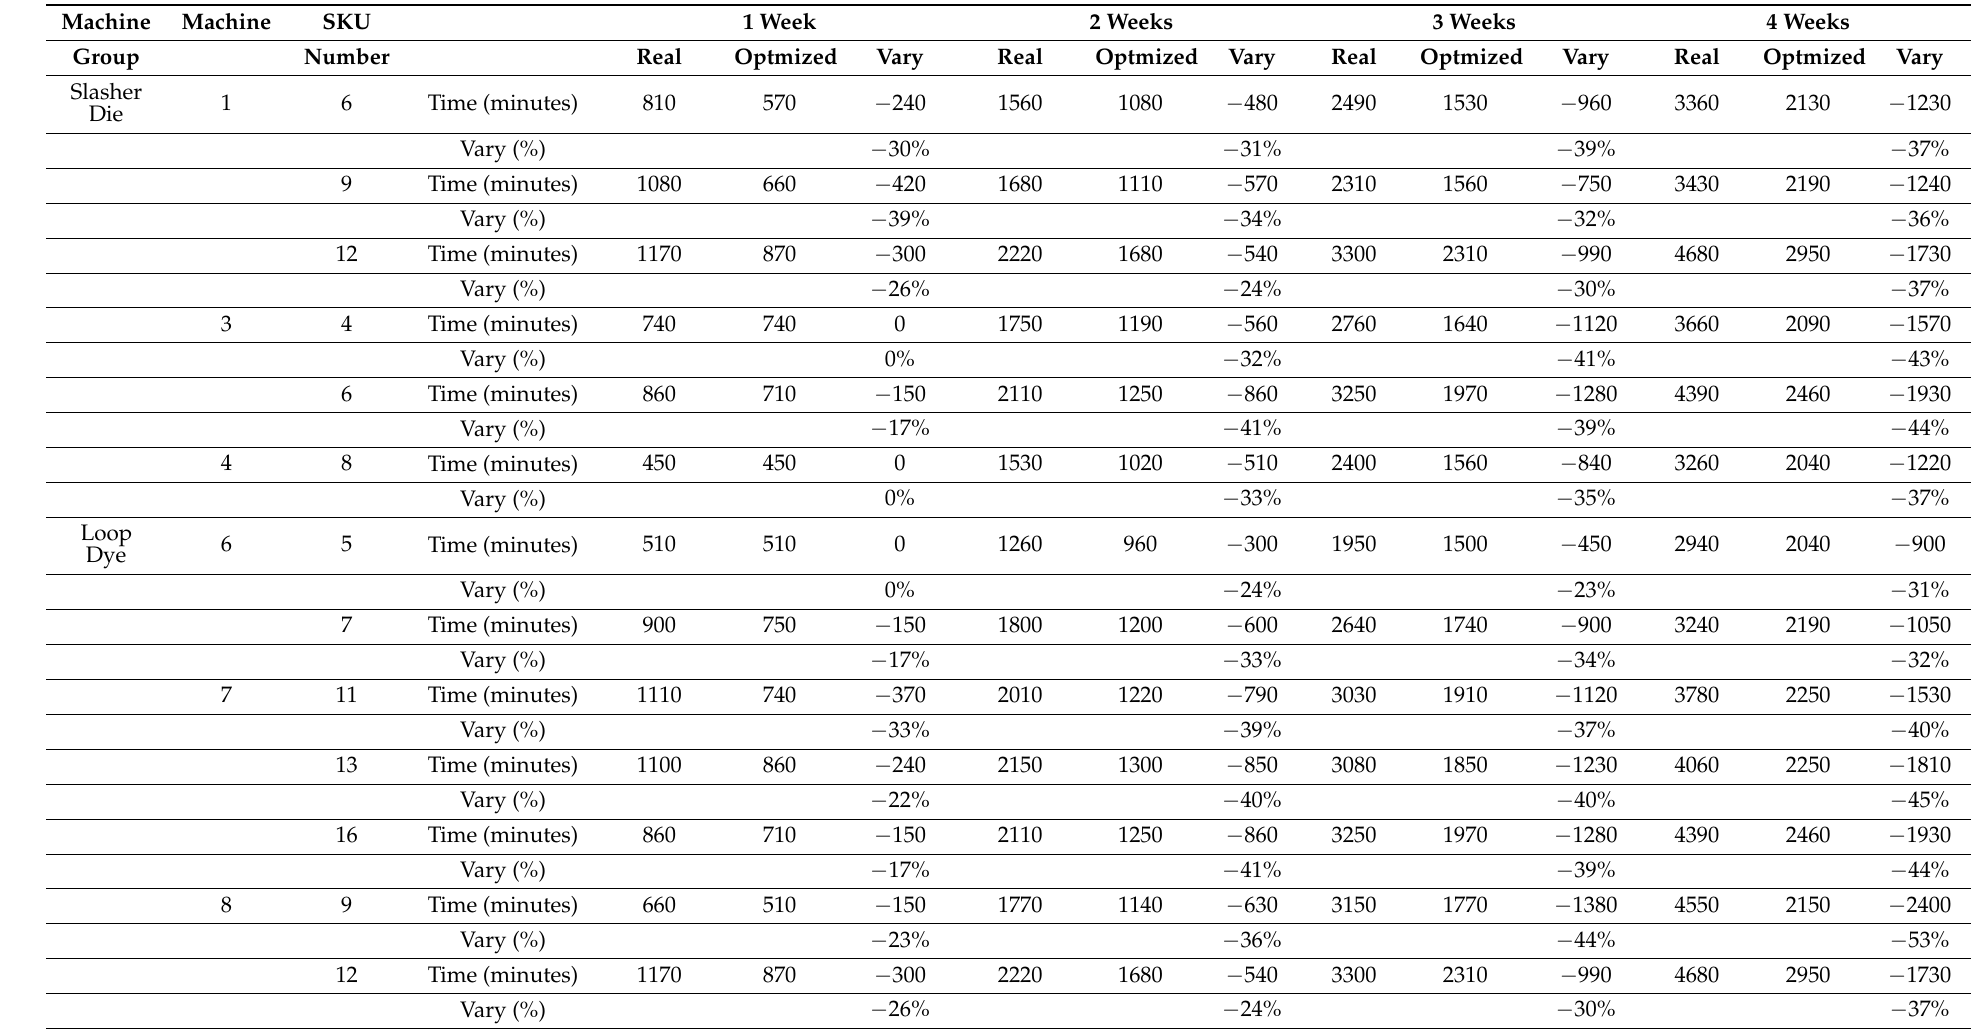
Table 6. Results of slasher dye and loop dye group, accurate and optimized setup